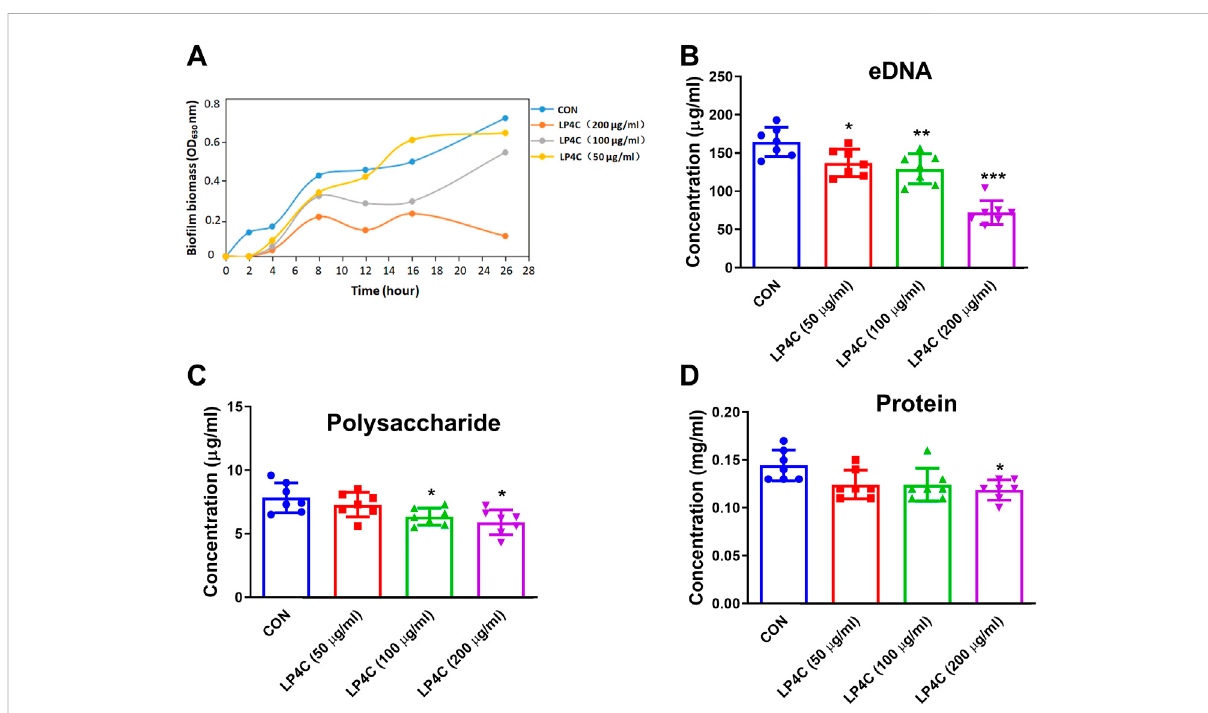
LP4C inhibits the extracellular bio fi lm matrix of MRSA. The inhibitory activity of LP4C (50, 100 and 200 μ g/ml) to the dynamic of MRSA USA 300bio fi lm biomass (A) . TheeffectofLP4C(50,100 and200 μ g/ml) to theconcentration ofeDNA (B) ,polysaccharide (C) and protein (D) , * p <